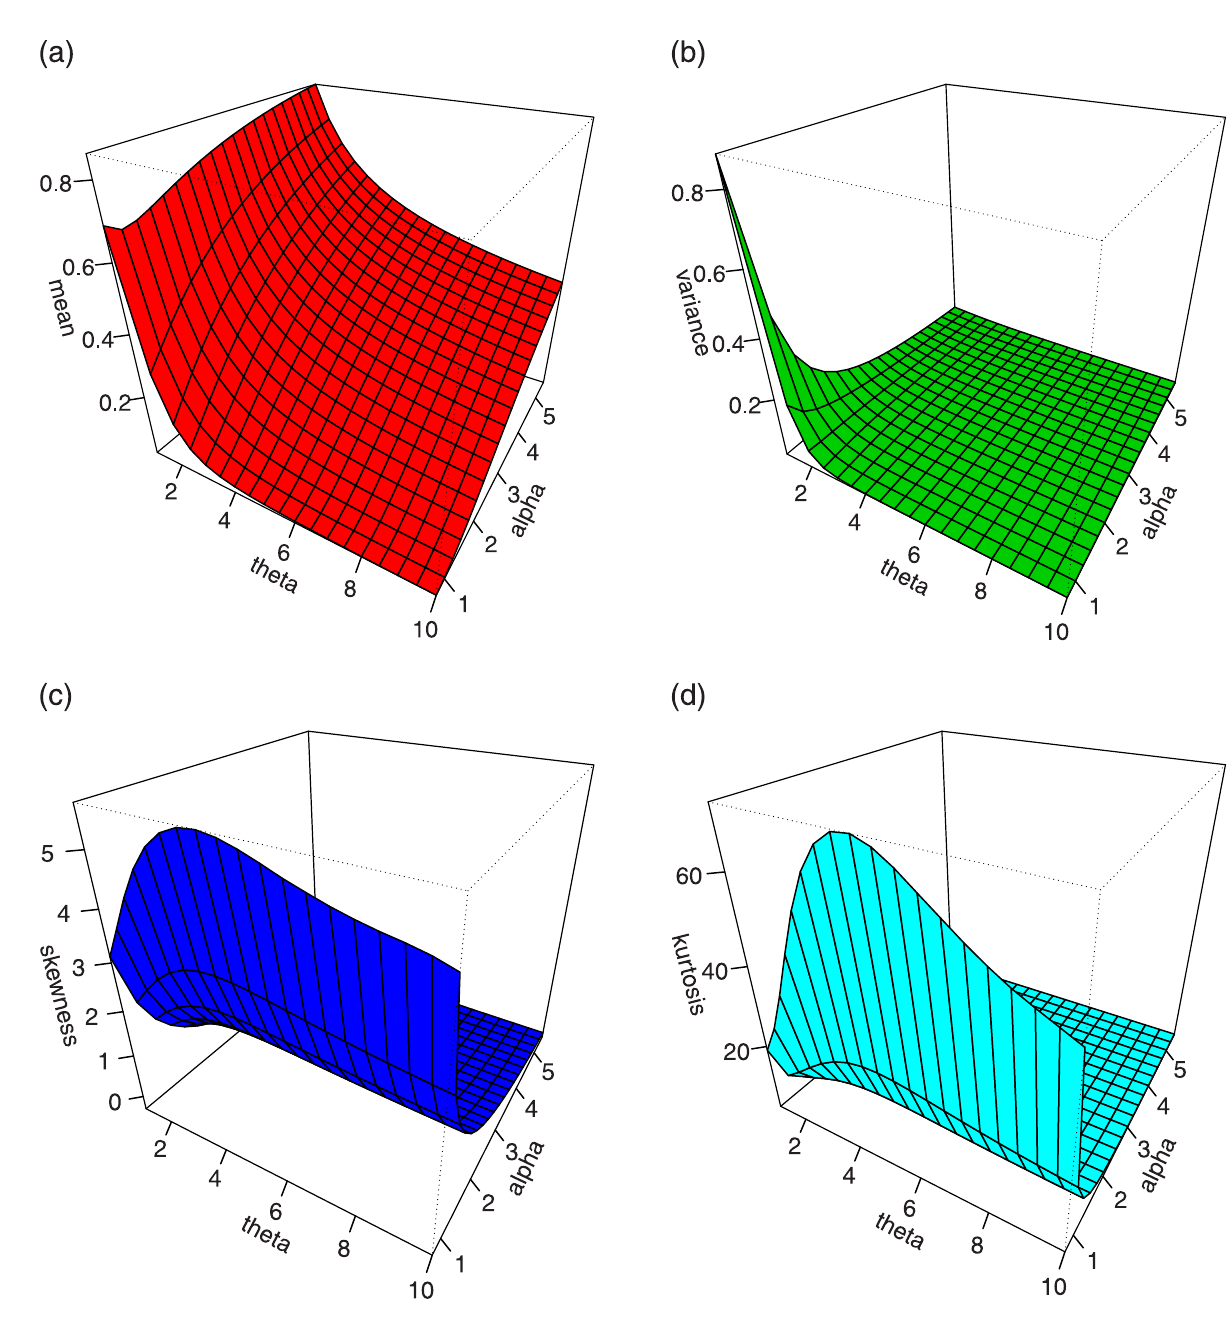
Fig 4. Plots for the mean, variance, skewness and kurtosis of the TI-HTW distribution.